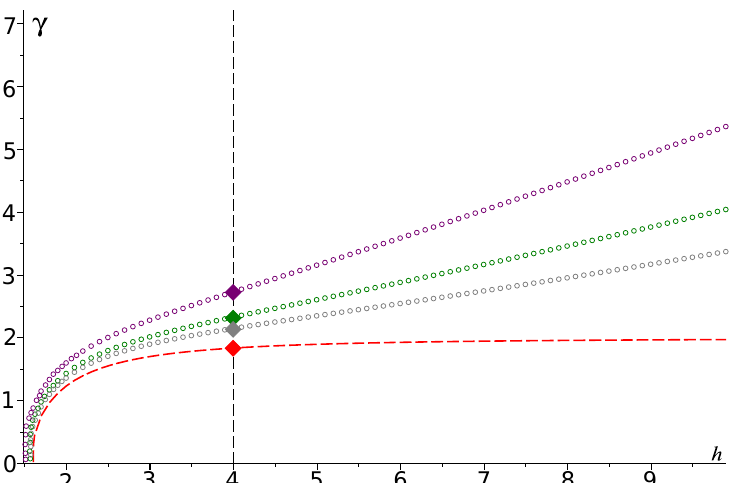
Figure 4. The first dispersion curves of problem for different values of parameter α : the purple Q curve corresponds to α = 5, the green curve corresponds to α = 2.5, the gray curve corresponds to α = 1.5 and, finally, the red one corresponds to α = 0 (this is the linear case). Diamonds stand for one eigenvalue of problem for different values of α , which are Q